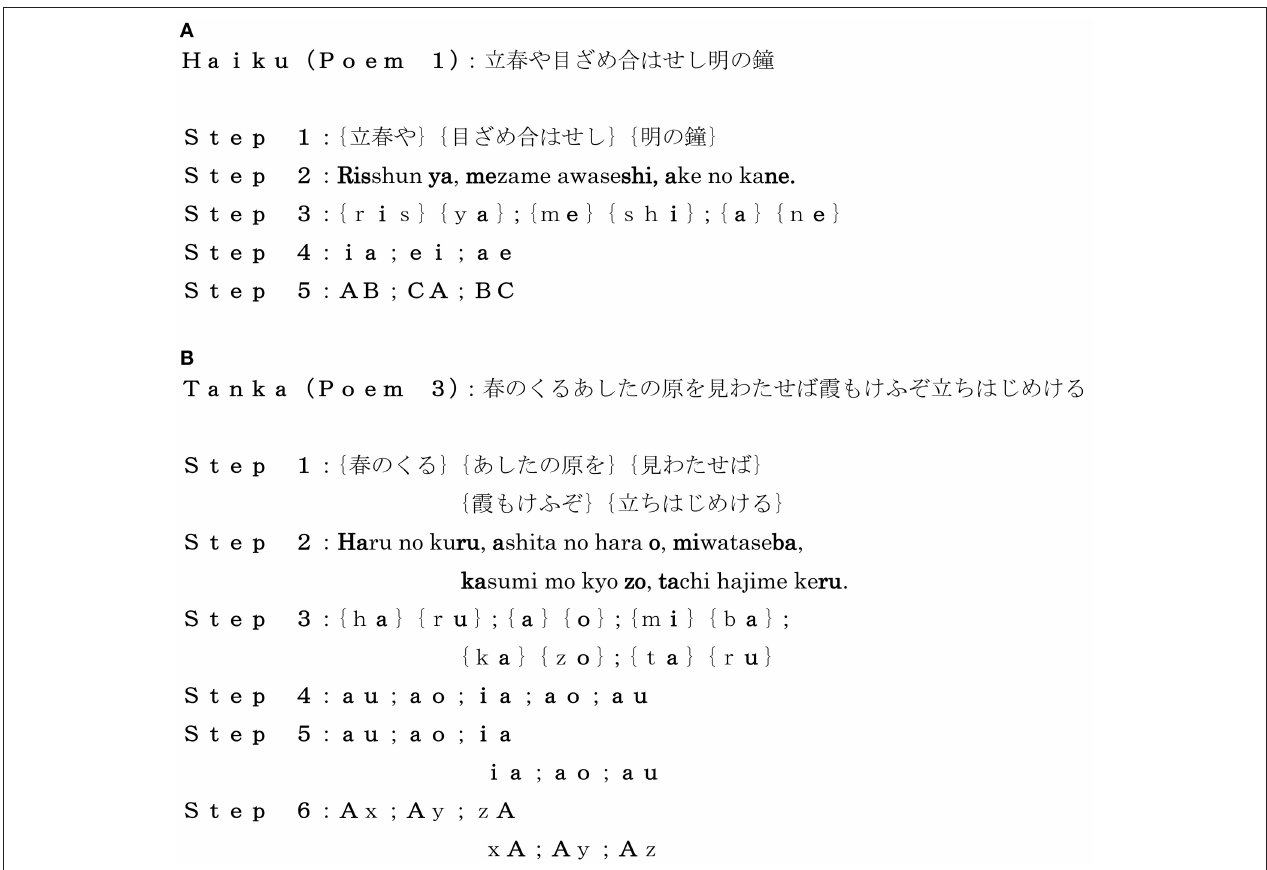
FIGURE 1 | Schematic illustration of generating six-dimensional sound arrangements. (A) Haiku (e.g., Poem 1 in the text). There are five steps that follow. Step 1 : Segmenting the poem into three phrases according to 5-7-5 syllables; Step 2 : Transliterating the original poem into the Roman alphabet; Step 3 : Choosing the head and the end syllables from the three phrases; Step 4 : Extracting a vowel from each individual syllable and arranging the six sounds like a string; Step 5 : Rewriting the string with a generic form. (B) Tanka (e.g., Poem 3 in the text). There are six steps that follow. Step 1 : Segmenting the poem into five phrases according to 5-7-5-7-7 syllables; Step 2 : Same as haiku; Step 3 : Choosing the head and the end syllables from the five phrases; Step 4 : Extracting a vowel from each individual syllable and arranging the 10 sounds like a string; Step 5 : Splitting the ten-dimensional arrangement into twin six-dimensional ones; Step 6 : Rewriting both strings in more generic